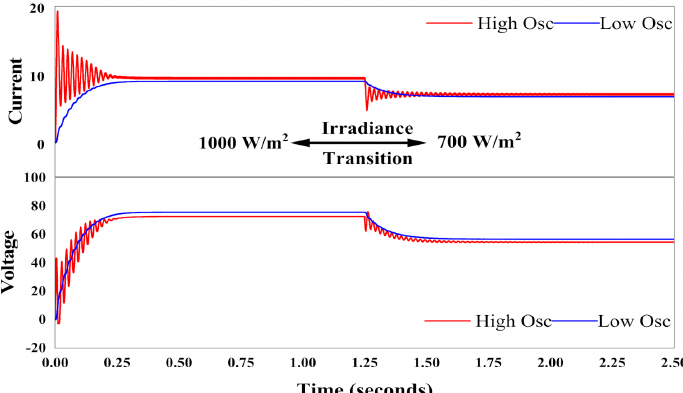
Figure 11. High and low oscillations V-I characteristics during irradiance transition (STC → UI-1).